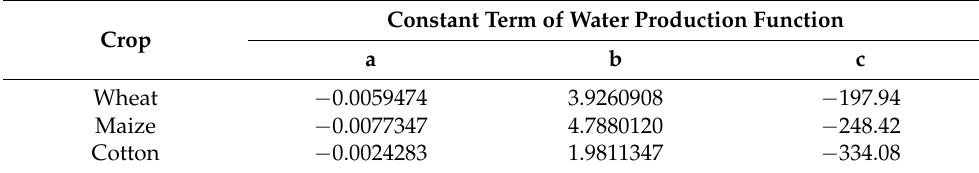
Table 2. Coefficients of water production function of crops. Crop